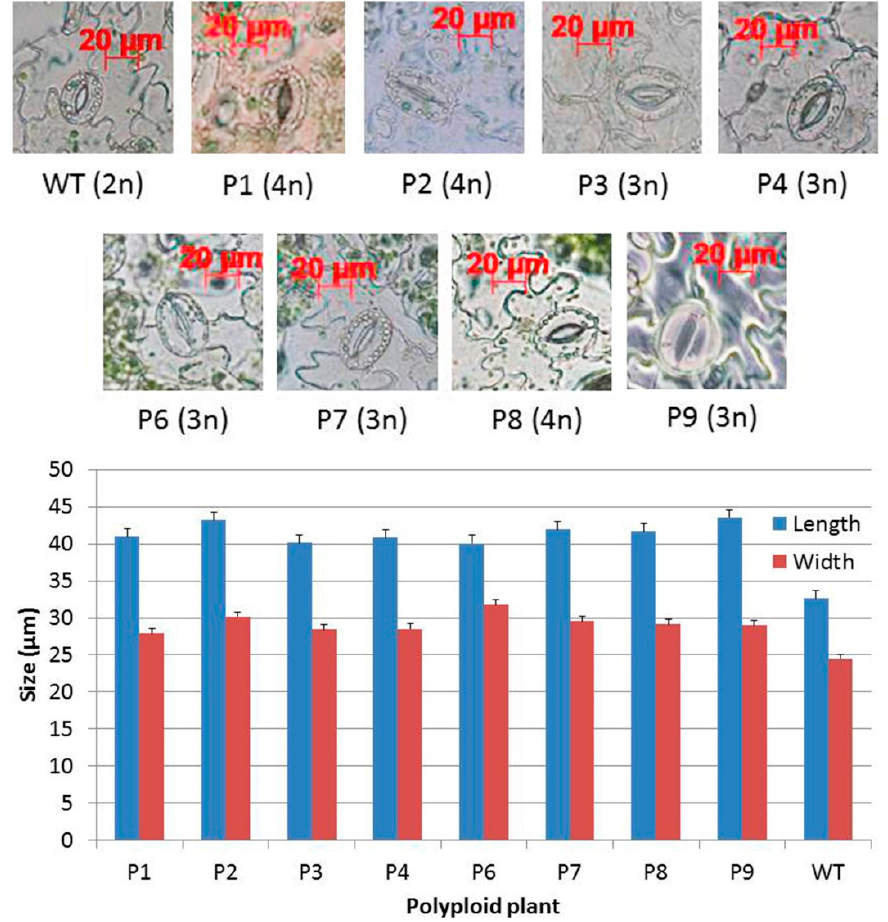
Figure 5. Leaf stomata in diploid wild-type and polyploid plants. Images of leaf stomata under a microscope are shown in the upper panel, and measurement of the size of stomata is shown in the lower panel.